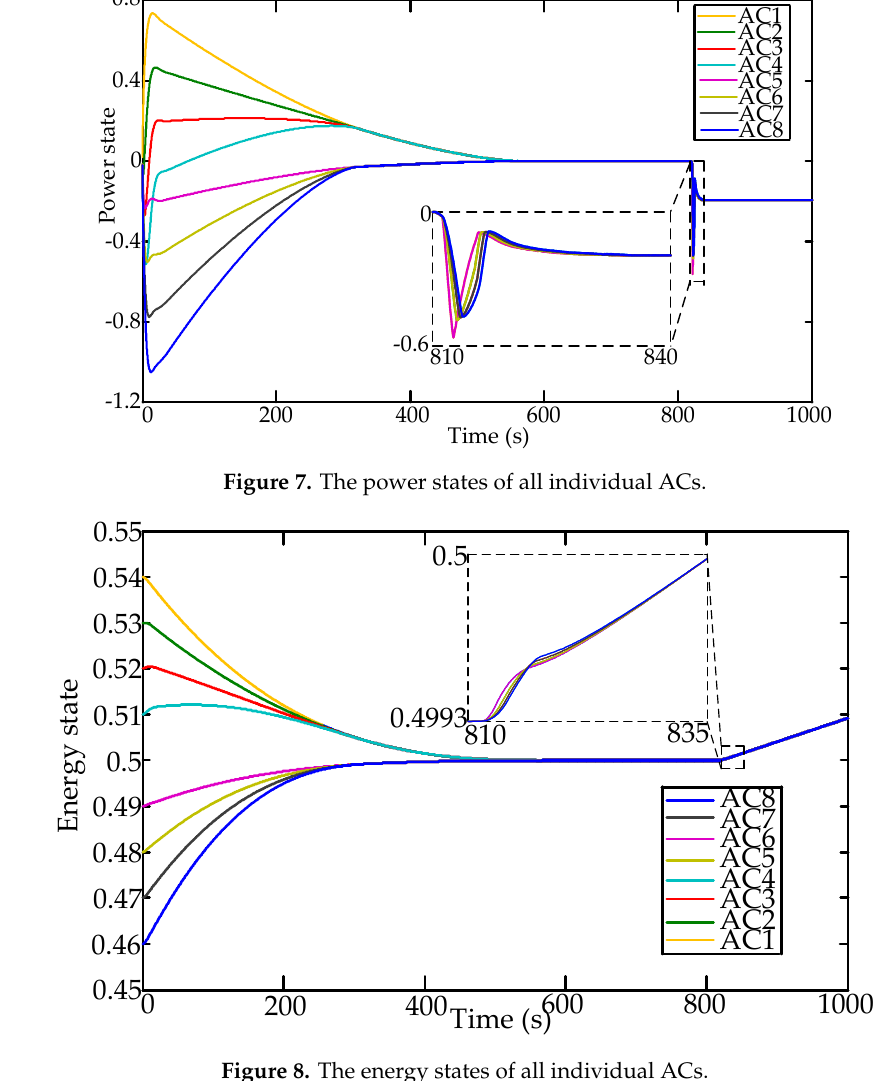
Figure 8. The energy states of all individual ACs.